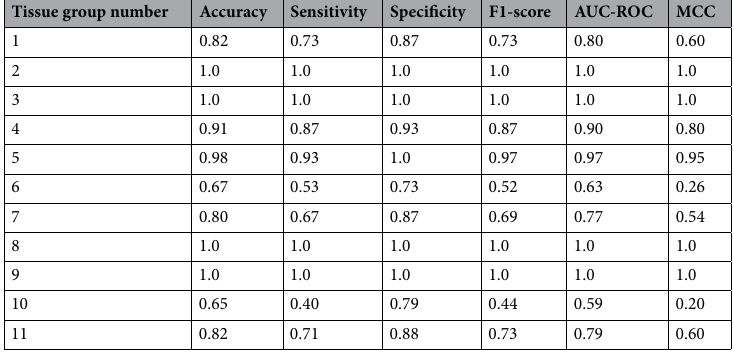
Table 5. Performance metrics for the binary classification of the burned porcine tissue and the synthetic tissue samples into two classes of static (0.3 mm/s) and surgical (2 and 8 mm/s) strain rates.